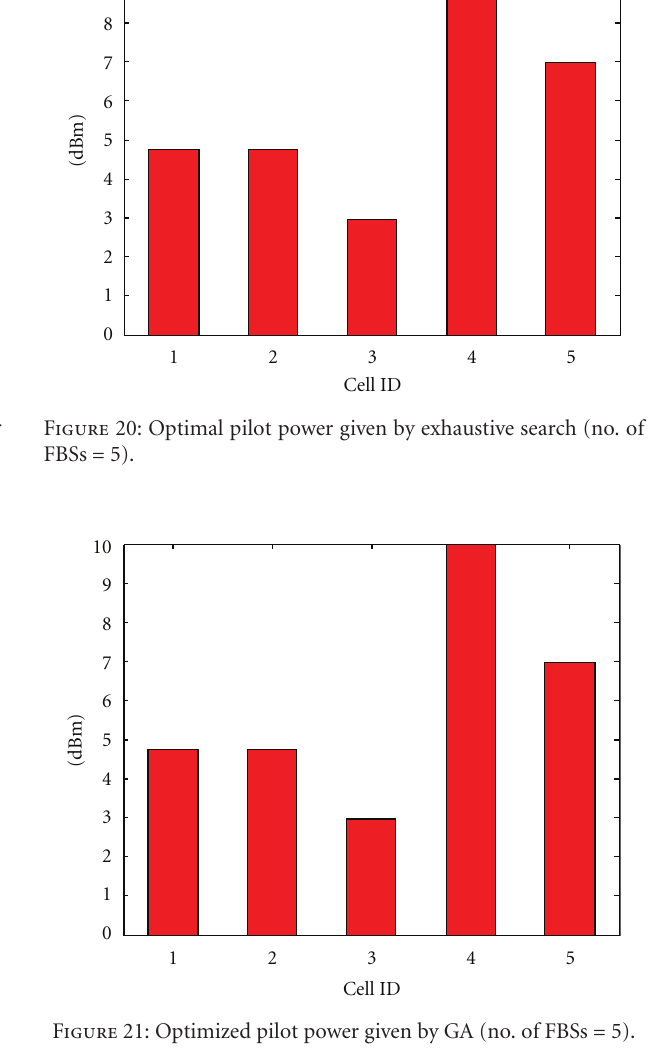
Figure 21: Optimized pilot power given by GA (no. of FBSs = 5).